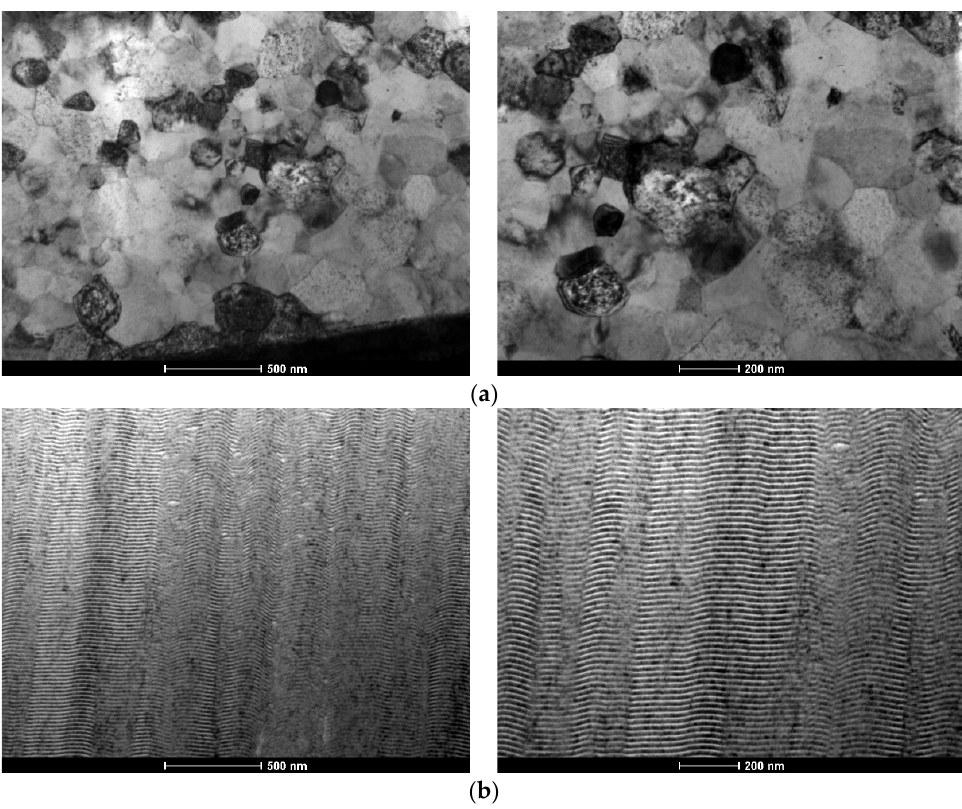
Figure 11. BF TEM cross-section micrographs of Al/Ni thin films after ignition by mode II. ( a ) φ = 0.05 mm W wire, and ( b ) φ = 0.20 mm W wire.